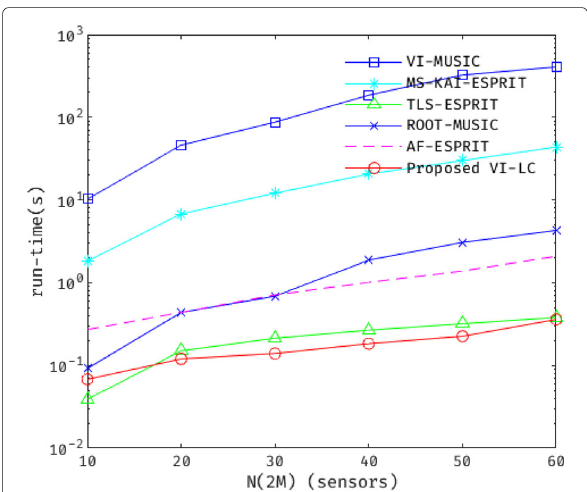
Fig. 2 Complexity comparison versus sensors